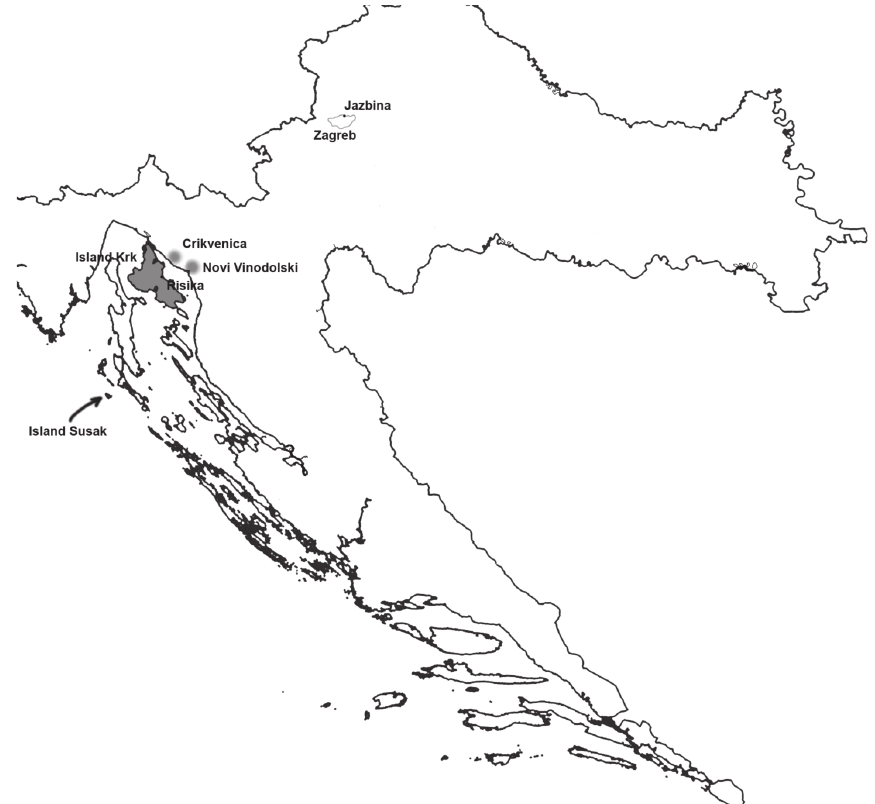
Figure 1. Locations of the National collection of Croatian native grape varieties at experimentation station Jazbina and the regional Risika collection on the island of Krk. Grey areas are vine-growing regions of the North Adriatic region from which native cultivars were collected and planted in the Risika